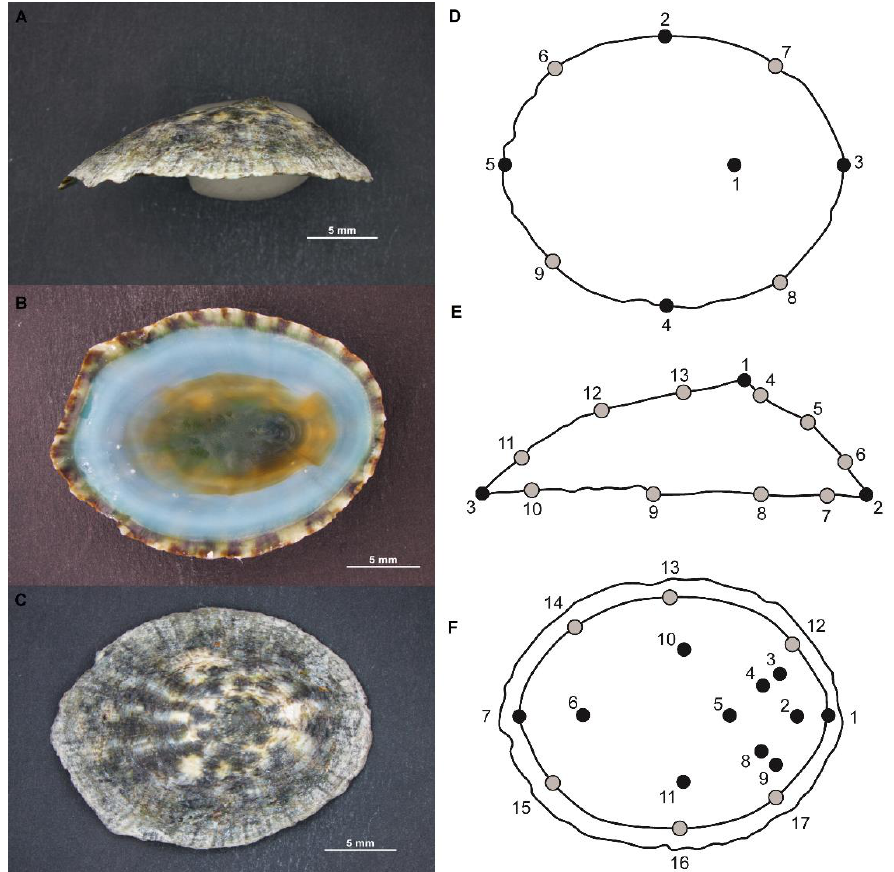
Figure 1. Lottia mesoleuca (Menke, 1851) representation in A: lateral, B: vental and C dorsal view and their schematic diagram with the representation of the distribution of landmarks in the three positions ( A , D )—Dorsal (9 landmarks), ( B , E )—Lateral (13 landmarks) and ( C , F )—Ventral (17 landmarks).